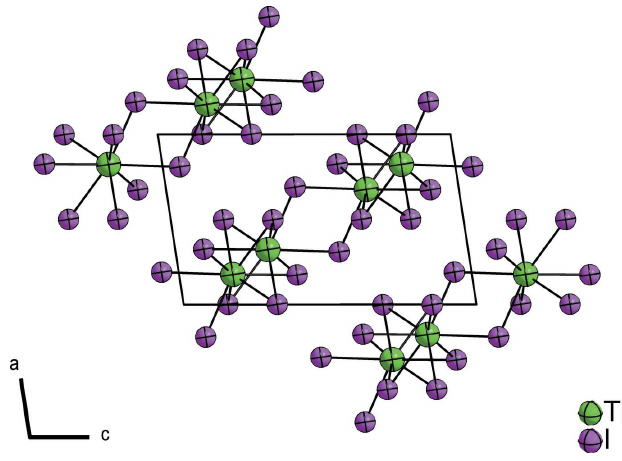
Figure 3 The crystal structure of ThI 4 in a projection along [010]. Displacement ellipsoids are shown at the 95% probability level.